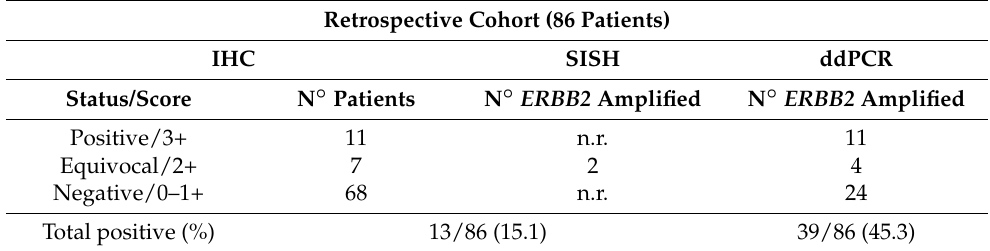
Table 2. HER2/ ERBB2 status of retrospective patients by IHC/SISH and droplet digital PCR